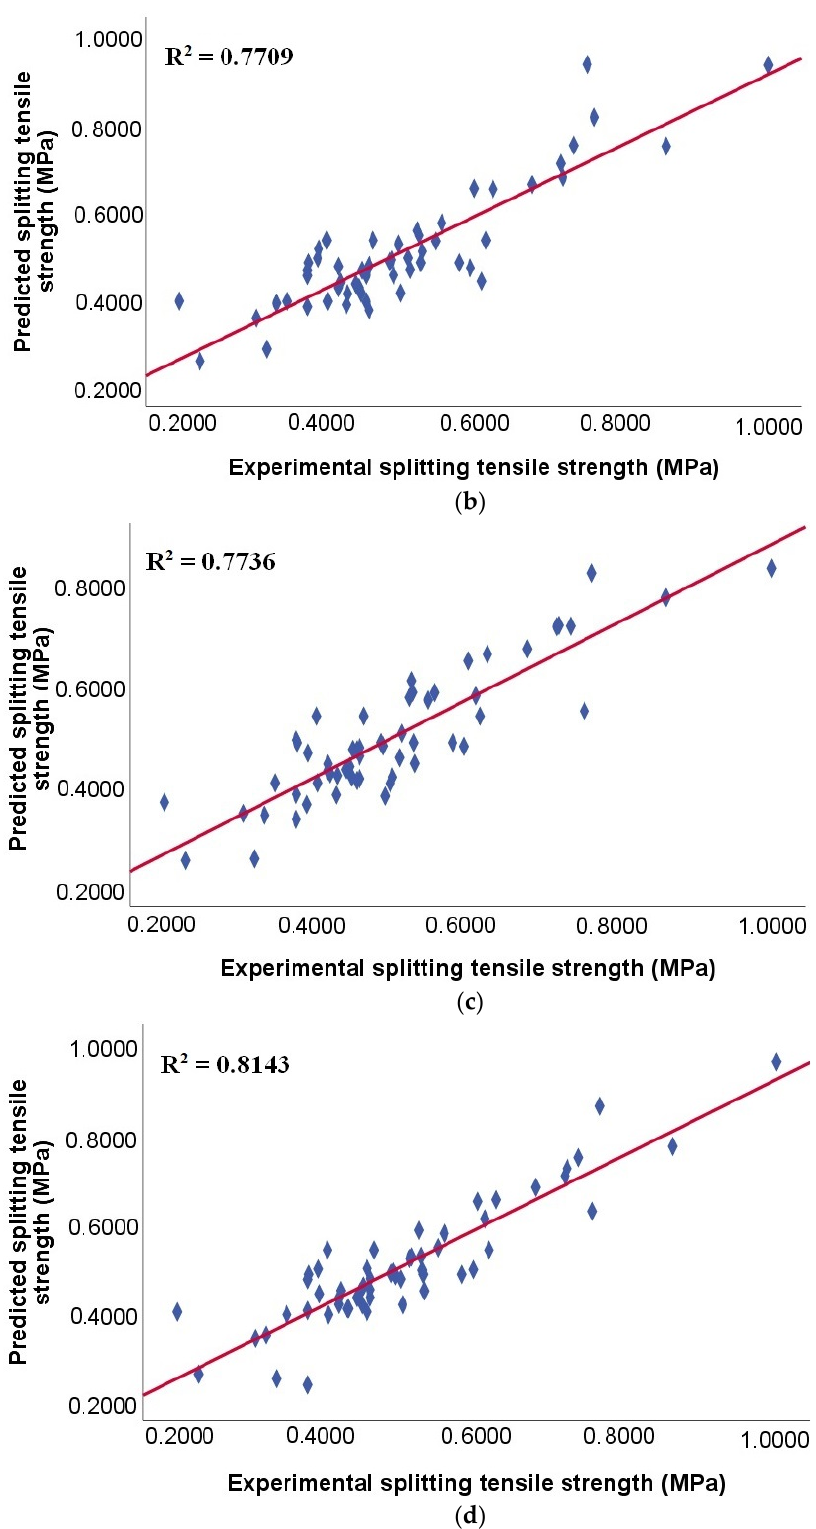
Figure 8. Comparison of the splitting tensile strength for models: ( a ) XG Boost; ( b ) GB; ( c ) CB; and ( d ) ETR, from testing data.